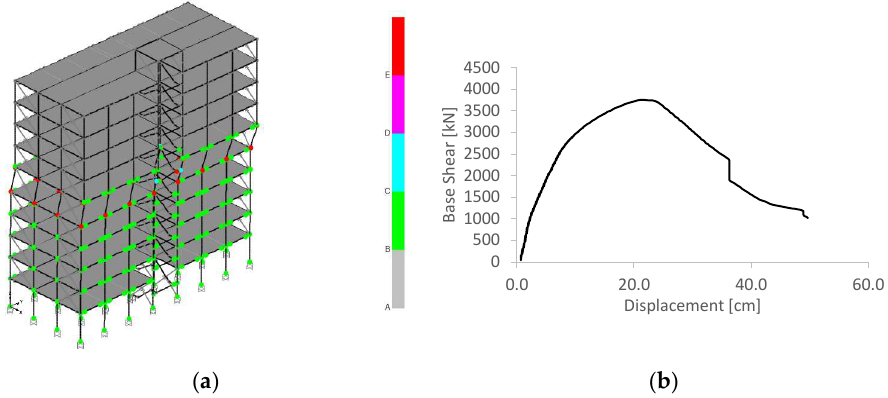
Figure 7. Pushover analysis, ( a ) deformed shape and ( b ) capacity curve in y directions.